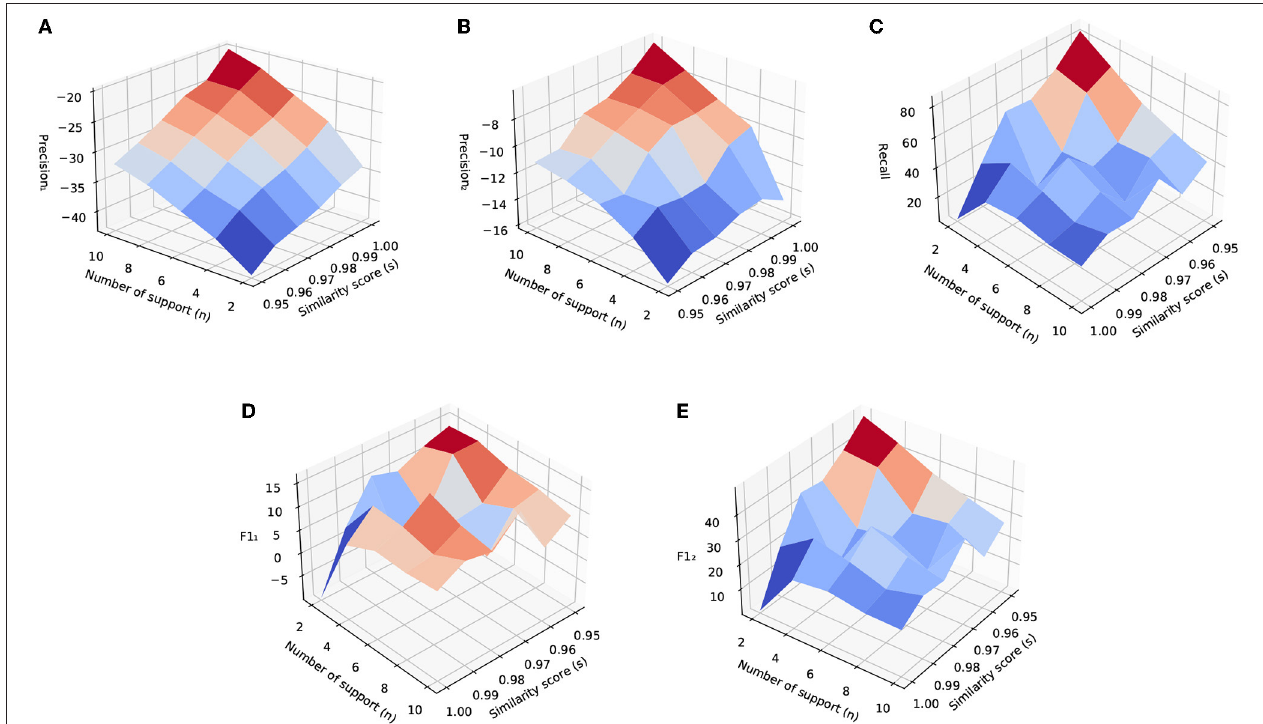
FIGURE 6 | Experimental results of CDR method by varying the number of support and similarity threshold. These results are using similarity scores based on utterance embedding vectors generated by fine-tuned BERT encoder. The unit of the vertical axis is the percentage. (A) Precision 1 . (B) Precision 2 . (C) Recall. (D) F1 1 . (E) F1 2 .